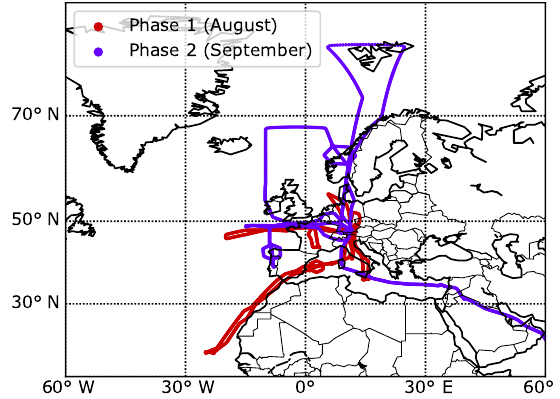
Figure 1. Flight paths of all analyzed flights during the TACTS and ESMVal campaigns. The flight paths of phase 1 and phase 2 are plotted in red and blue,